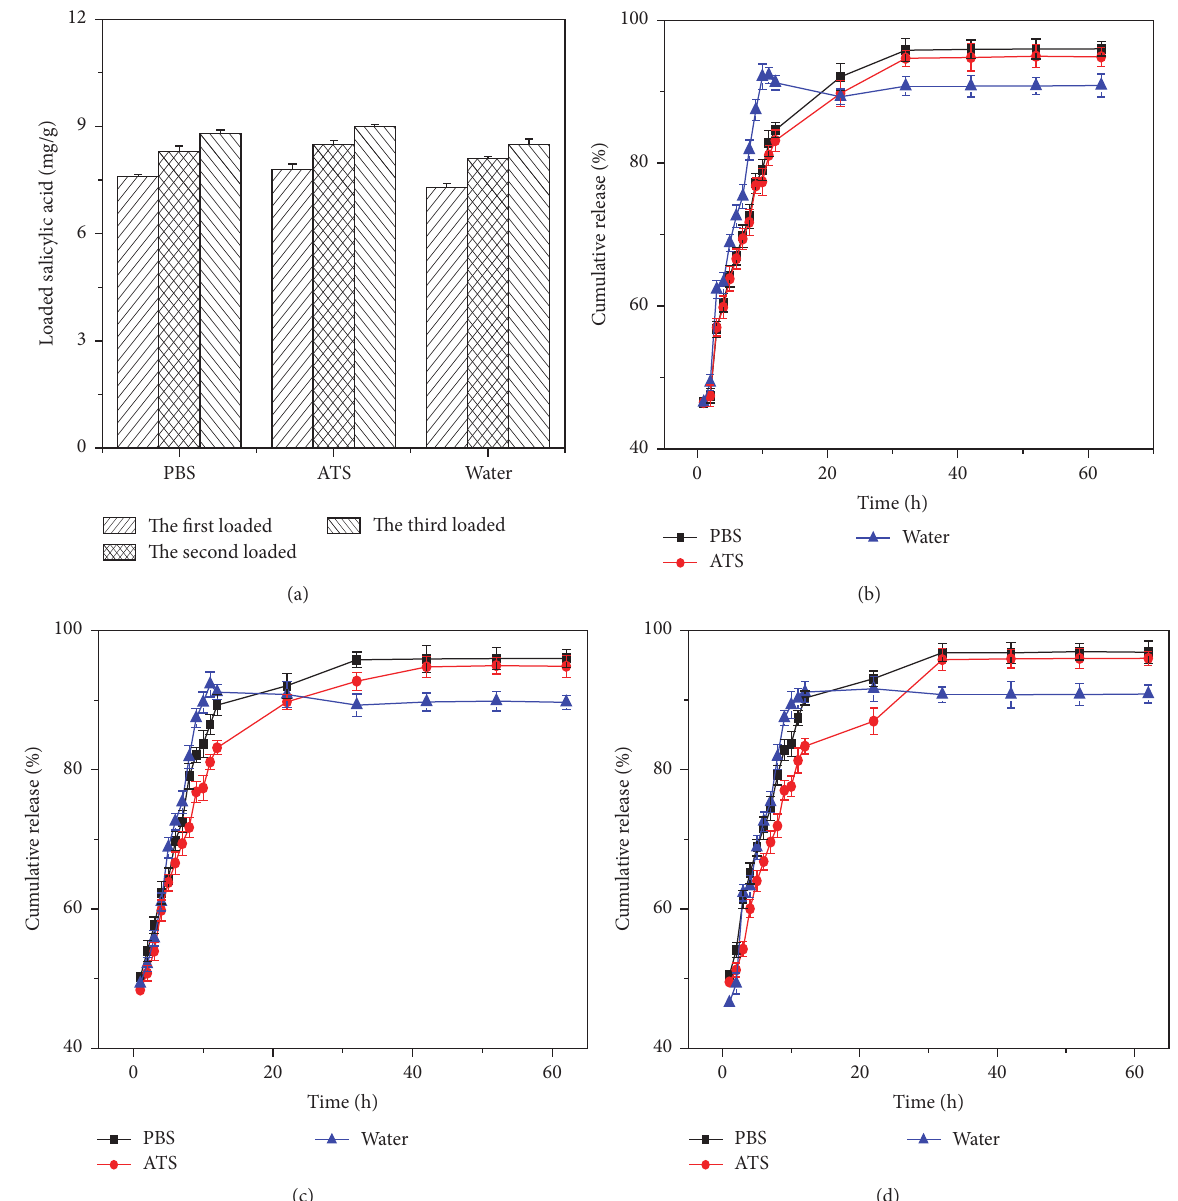
Figure 7: (a) Loaded salicylic acid amount in hydrogels for three times in different media, (b) salicylic acid release behavior in different media for first drug-loading, (c) salicylic acid release behavior in different media for second drug-loading, and (d) salicylic acid release behavior in different media for third